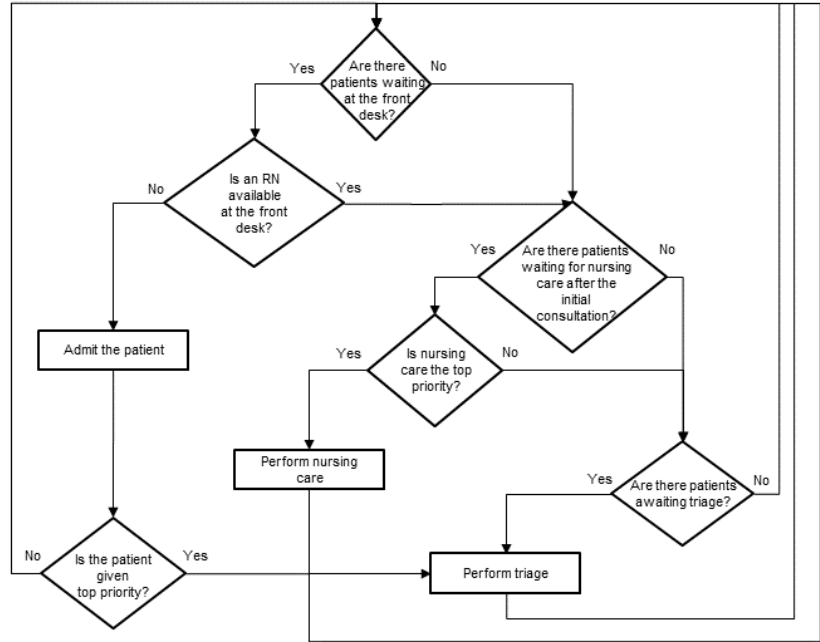
Figure 4. Example of RNs’sorting rules. Actions are presented in the rectangular boxes and conditions for decision in the diamond-shaped boxes. RN: registered